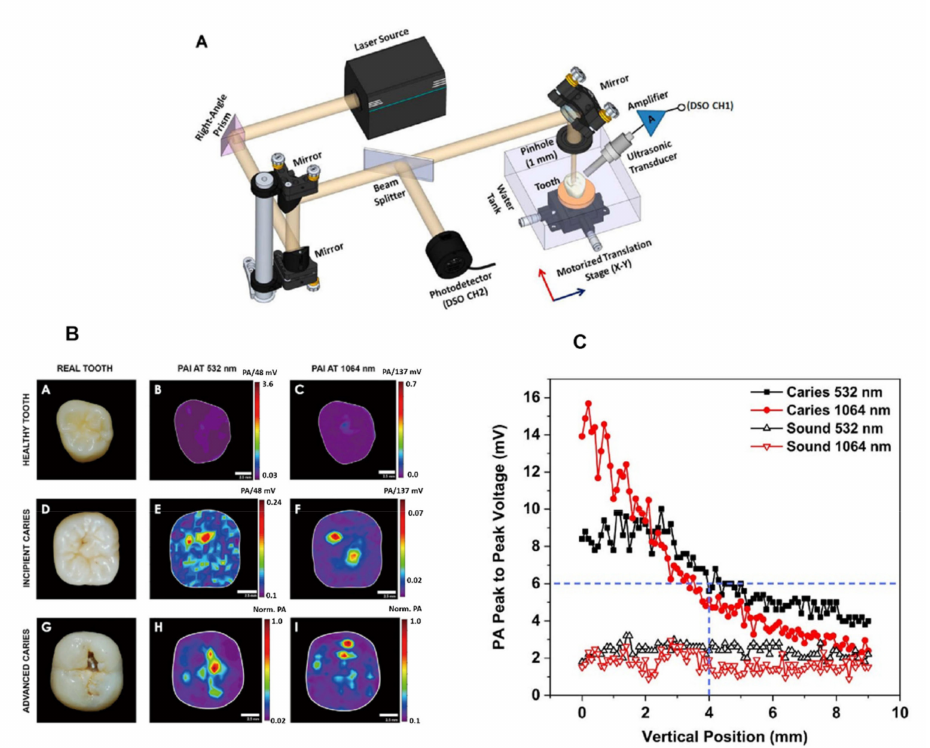
Figure 10. ( A ) Schematic diagram of the lab-made photoacoustic imaging system. ( B ) Photoacoustic (PA) images of sound and carious teeth at 532 nm and 1064 nm with a 5 MHz photoacoustic detector. The rows represent the sound tooth ( A – C ); incipient caries ( D – F ); and advanced caries ( G – I ) groups. From the left to the right, the first column shows the photographic image of the representative samples, and the second and third columns show the corresponding PA images at 532 nm and 1064 nm, respectively. PAI: photoacoustic imaging. ( C ) Peak to peak voltage for the depth of the photoacoustic signal in a tooth with incipient caries. The scale bar is 2.5 mm long. From ref. [83] with